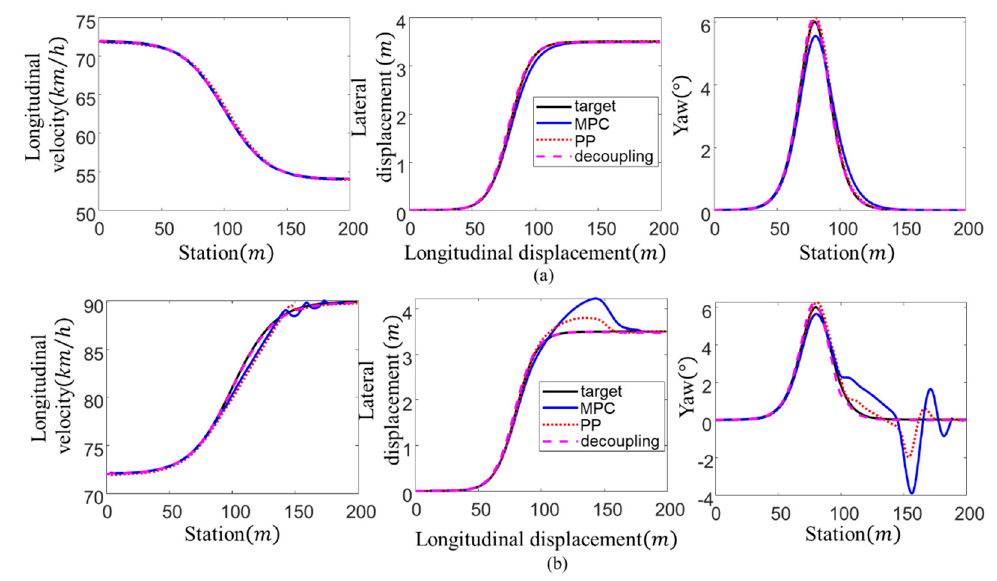
Figure 10. Trajectory tracking results on low-adhesion road: ( a ) steering with deceleration, ( b ) steering with acceleration.